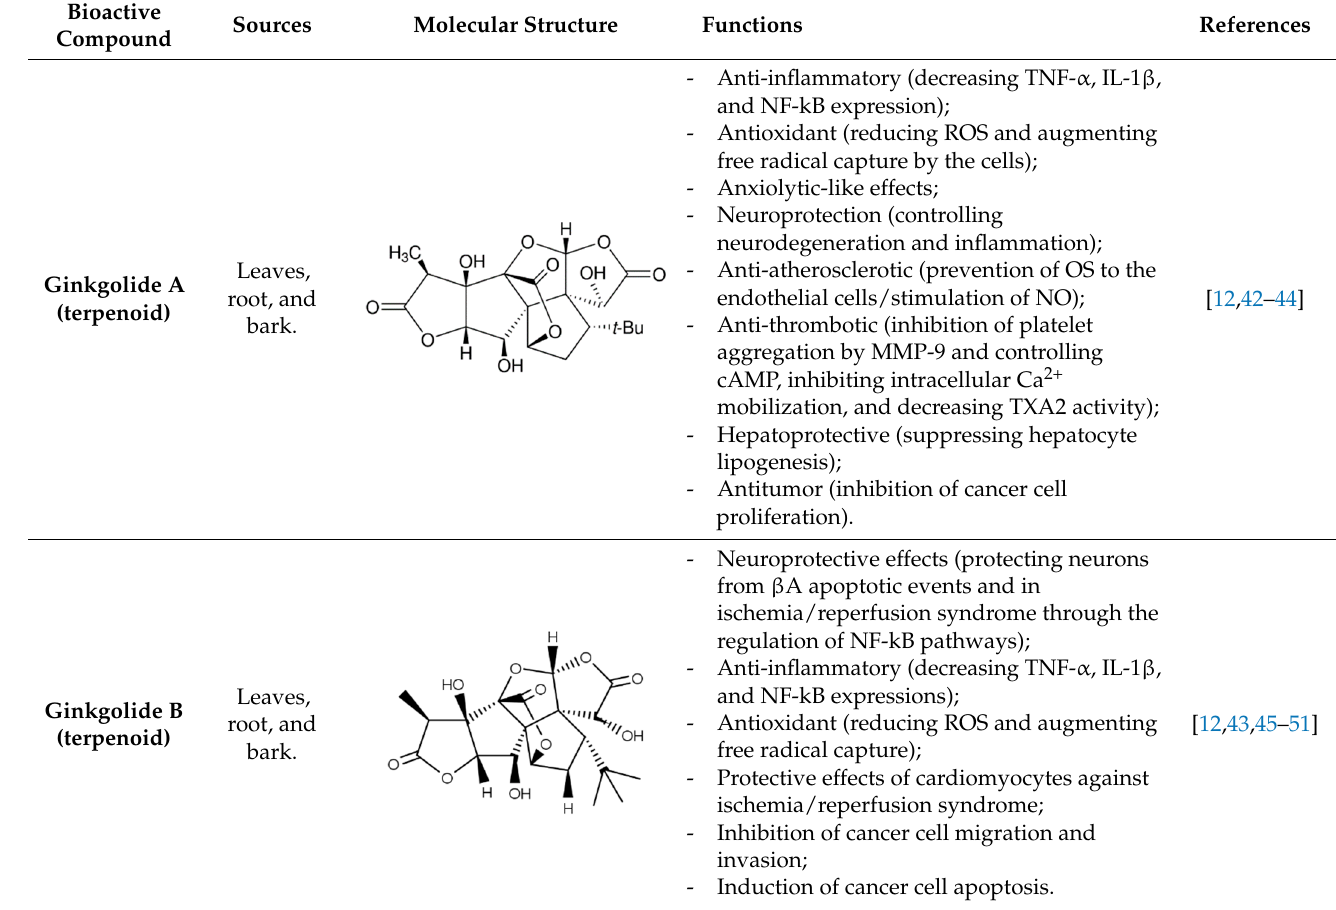
Table 3. Bioactive compounds of Gingko biloba and their effects on aging-related conditions.